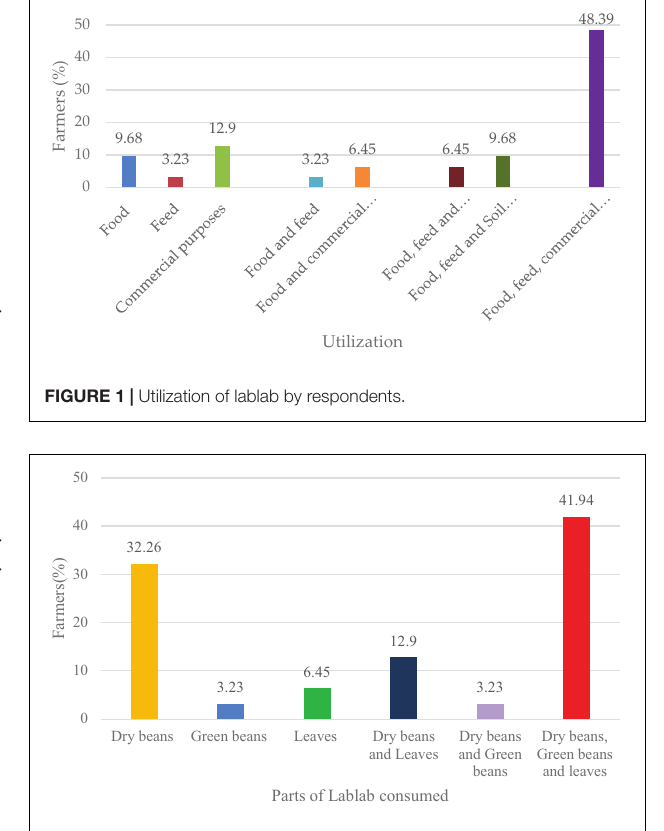
FIGURE 2 | The parts of lablab consumed as food by the